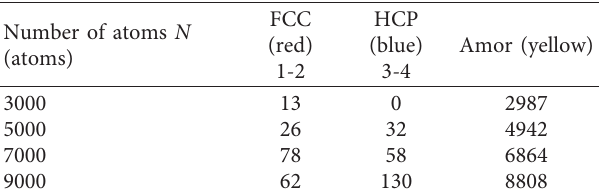
Figure 4: Stress-strain curve for amorphous aluminium with different numbers of atoms. Table 3: Common neighbors of FCC, HCP, and Amor structures in samples with different numbers of